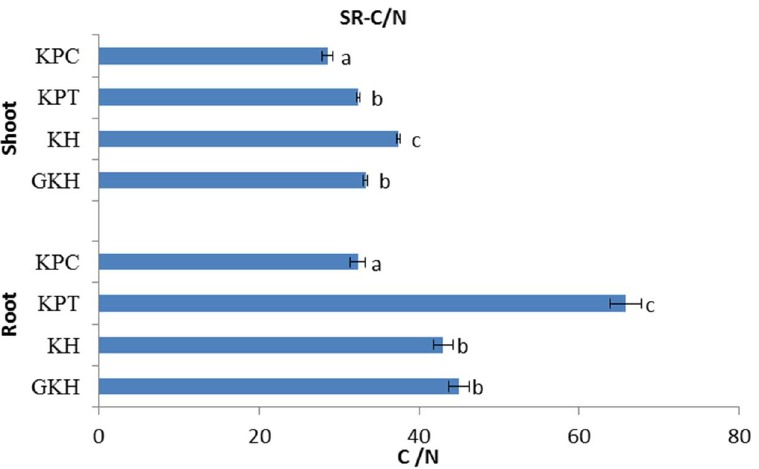
Figure 6. C/N of the plant community aboveground (Shoot) and belowground (Root) at different grazing intensities: GKH (3.75 ± 0.75 sheep/ha), KH (7.25 ± 0.25 270 sheep/ha), KPT (8.50 ± 0.35 sheep/ha), and KPC (11.75 ± 0.95 sheep/ha). Notations: different letters indicate significant differ- ences between pastures ( α = 0.05).